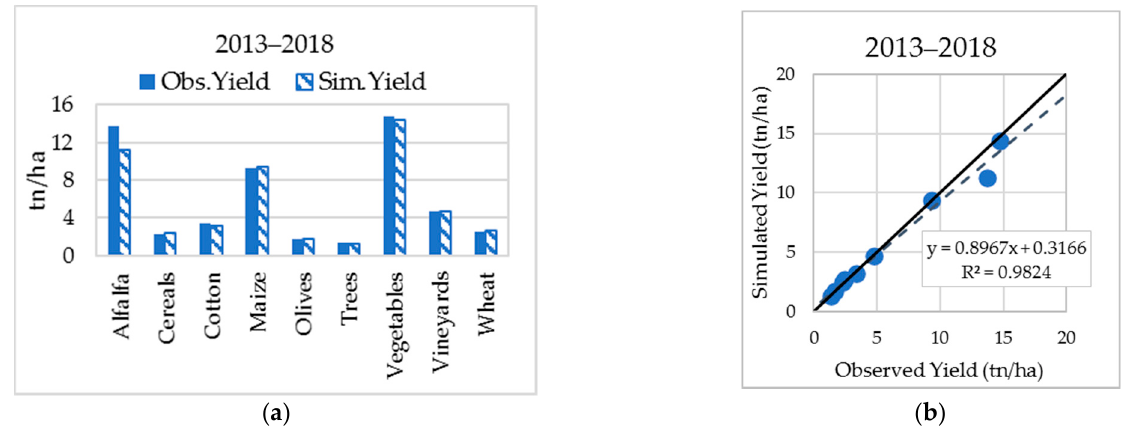
Figure 14. ( a ) Average simulated crop yield per crop type, and ( b ) spatially simulated crop yields against spatially observed crop yields for the validation period 2013–2018.